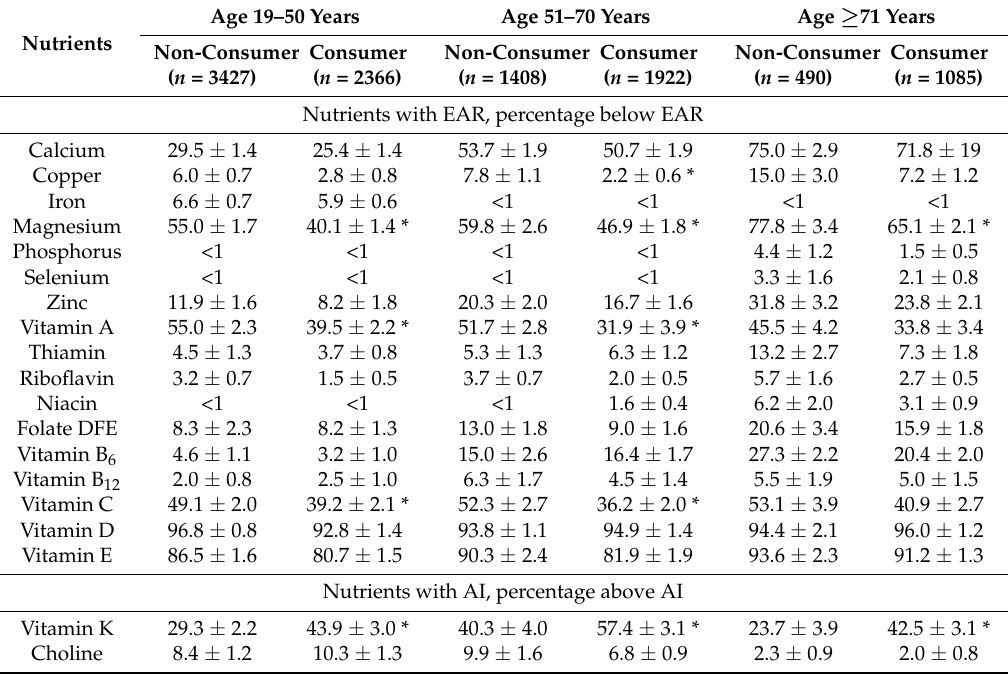
* Significant difference for consumer and non-consumer within age subgroups at p < 0.01. Table 2. Percent of adult (19+ years old) population below Estimated Average Requirement (EAR) or above Adequate Intake (AI) of nutrients from foods only. NHANES 2009–2012 gender combined